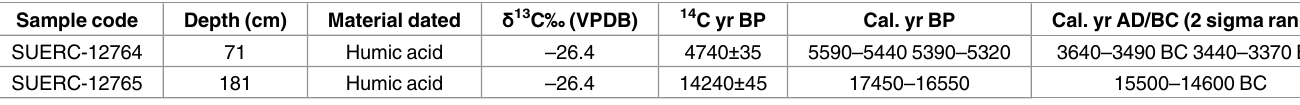
Table 1. Results of radiocarbon